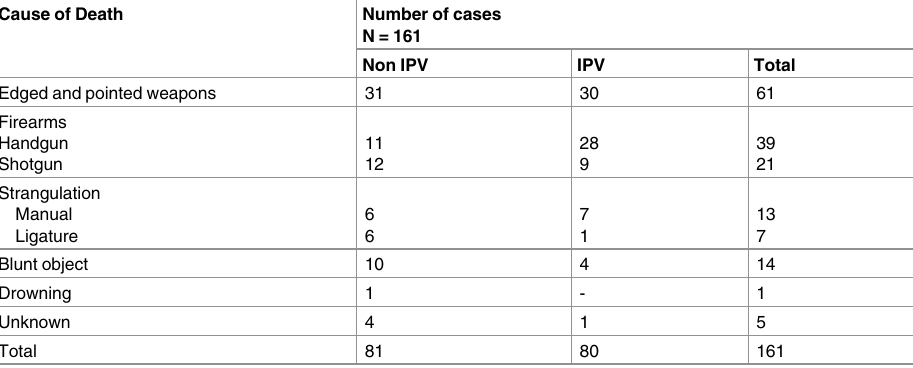
Table 4. Case distribution by cause of